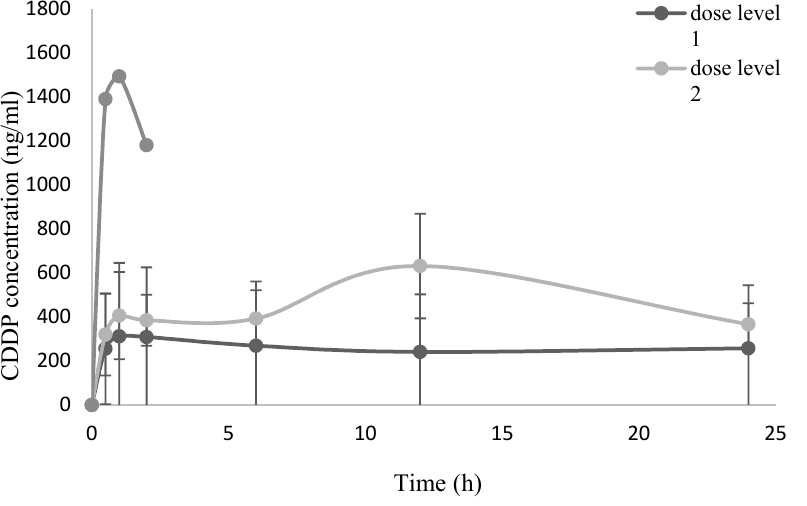
Figure 1. CDDP plasma concentration (ng/mL) over time after PIPAC procedure. Results are expressed as mean ± SD.